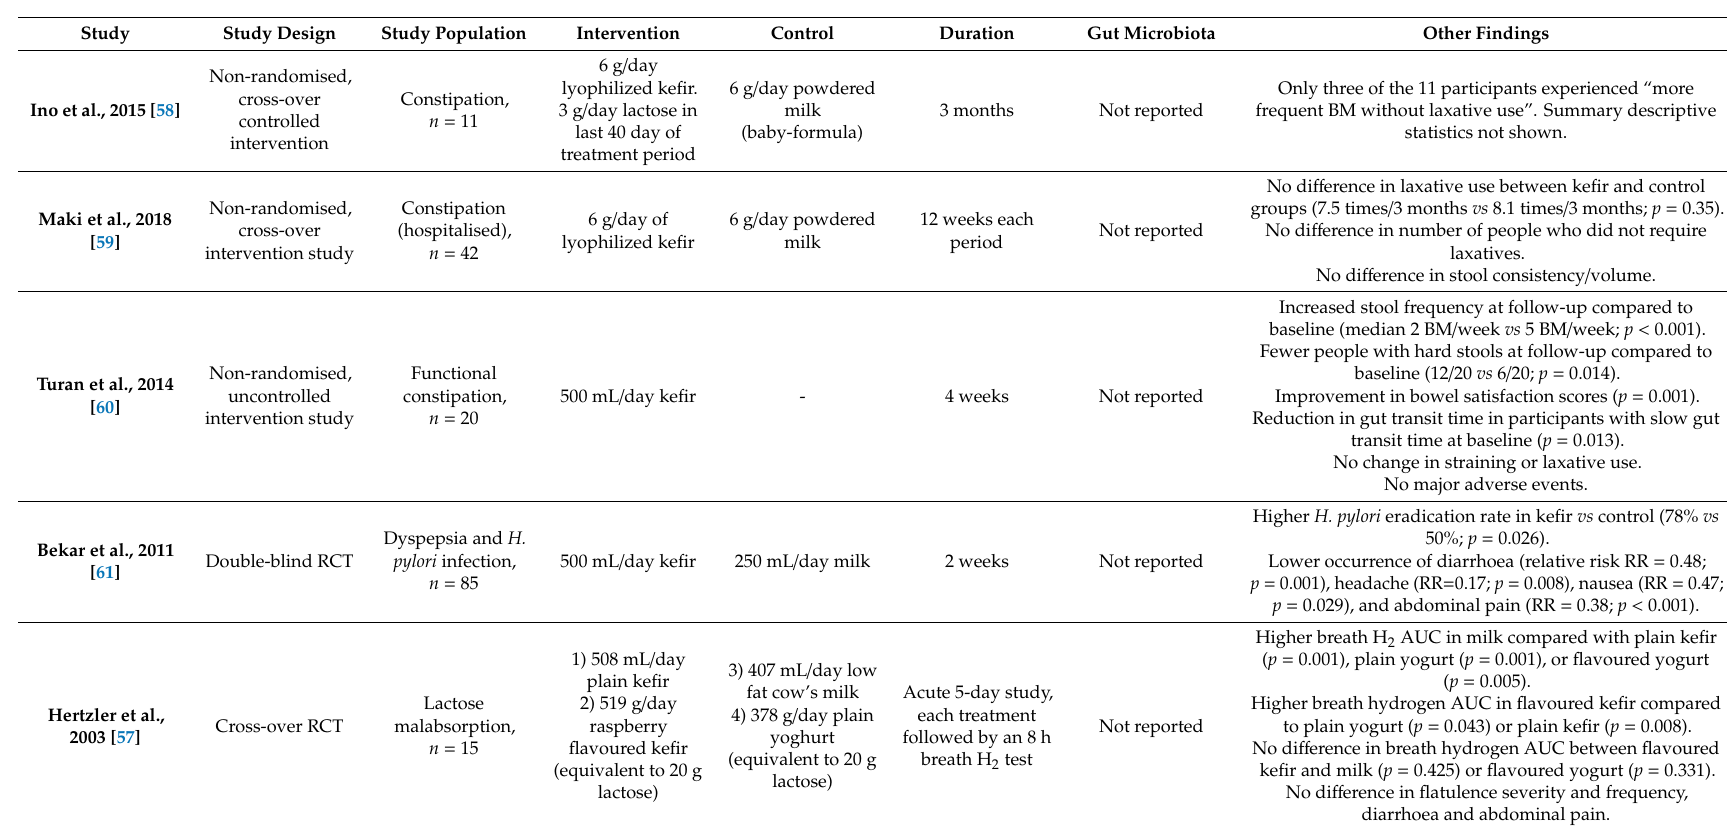
Table 2. Summary of interventions studies investigating the impact of kefir in gastrointestinal health and